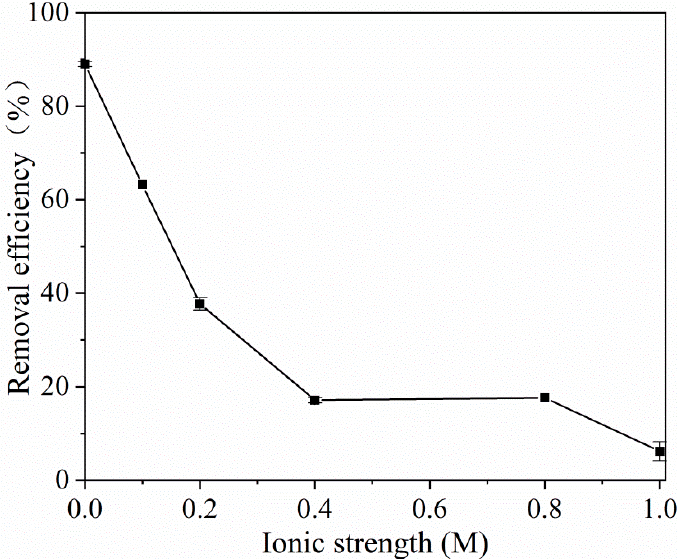
Figure 4. Ionic strength effect on the adsorption of tetracycline. ( C 0 = 20 mg L − 1 , V = 10 mL, m (adsorbent) = 20 mg, T = 25 °C, t = 120 min).